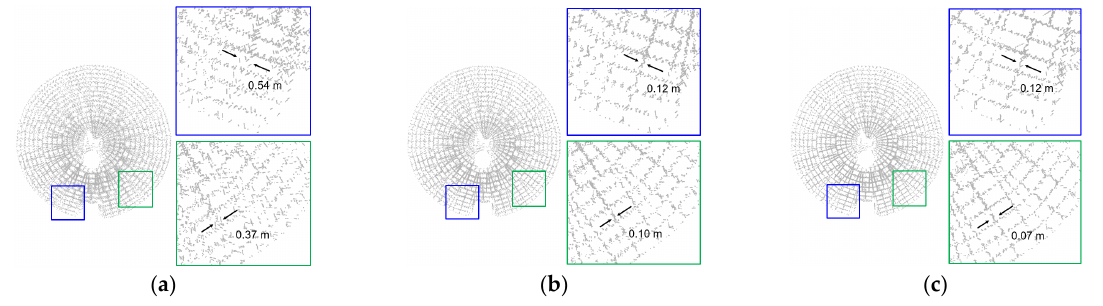
Figure 41. Extracted edge points from the scans in the West Lafayette dataset before/after the full fine registration: ( a ) partial fine registered edge points, ( b ) full fine registered edge points using roof/stringer features, and ( c ) full fine registered edge points using the roof/stringer/ground/wall fea- tures. initial/final RMS of the fitting errors for the roof/stringer